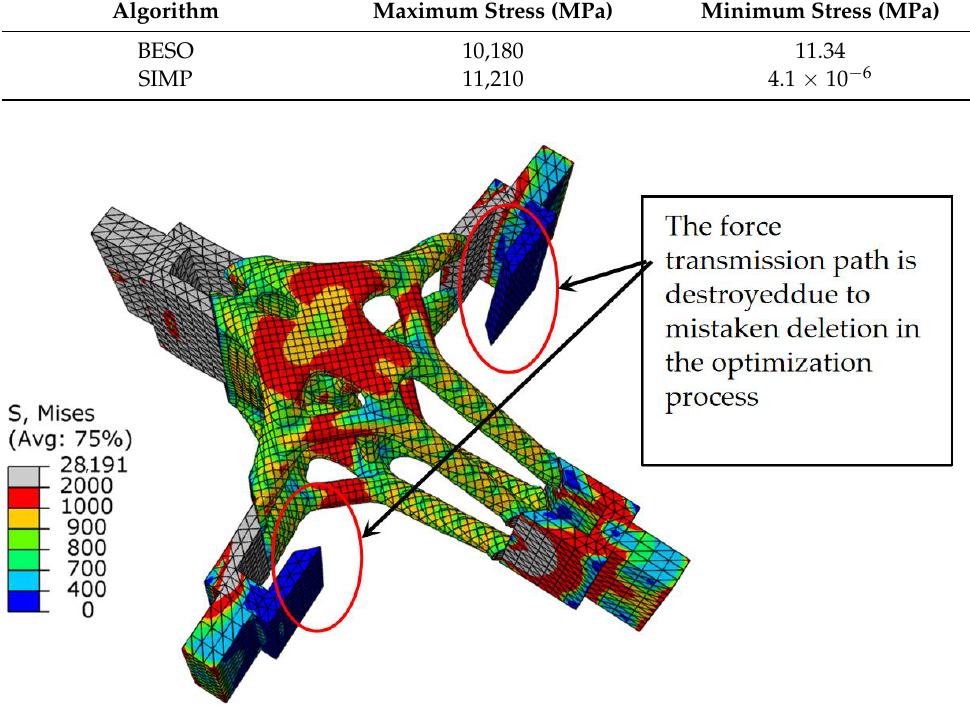
Figure 15. Stress nephogram of SIMP optimization results under shear conditions.